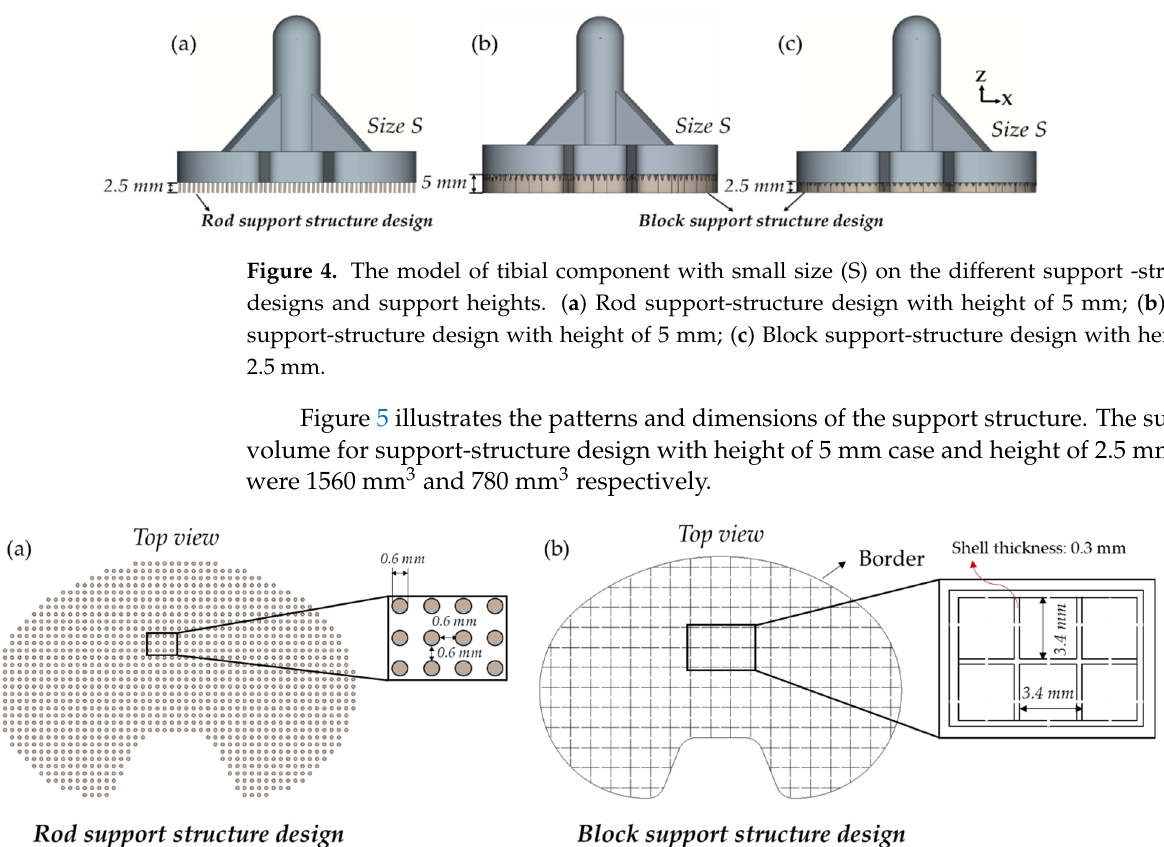
** S = small, M = medium, and L = large.